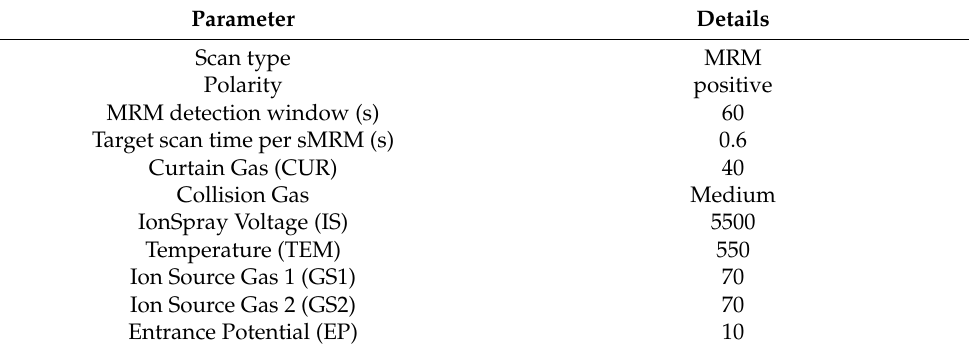
Table 3. Mass spectrometry